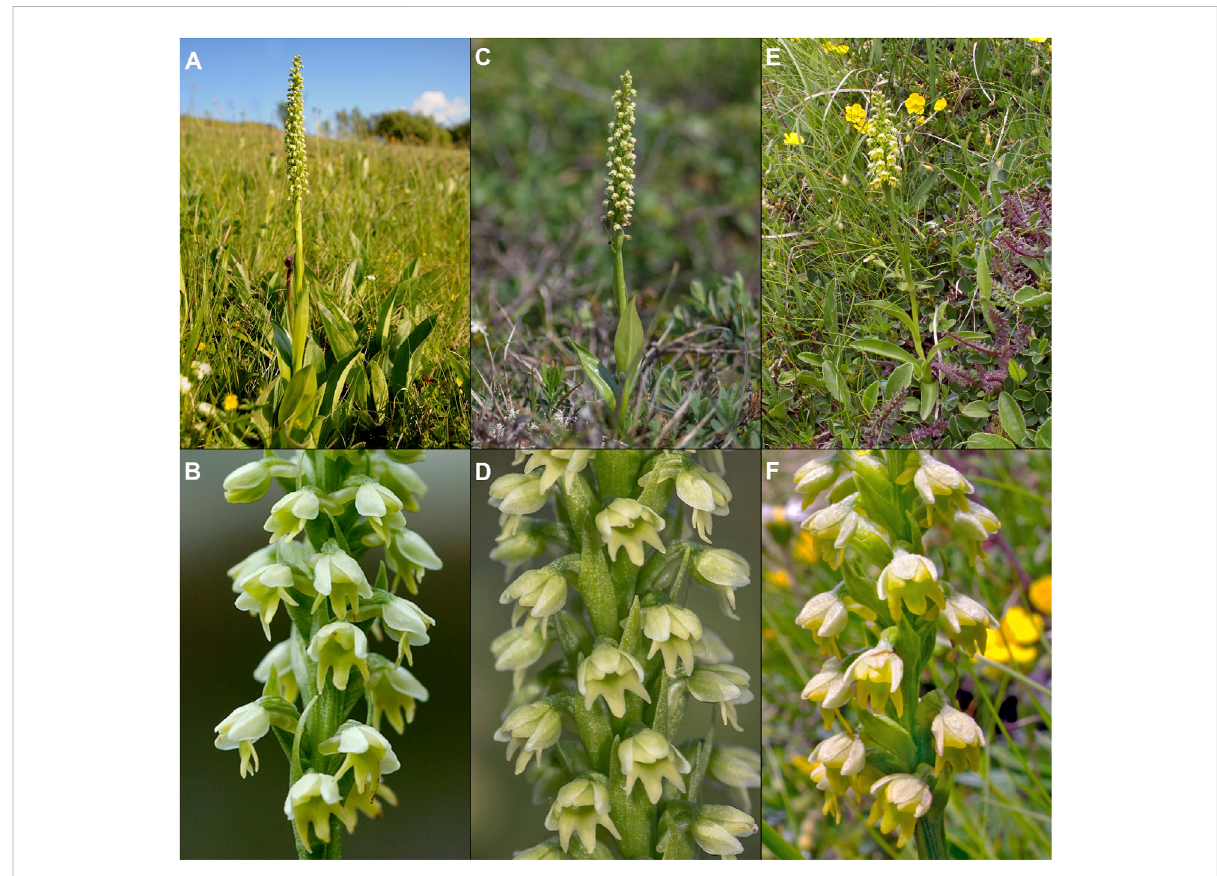
FIGURE 1 Photographs of the small-white orchid in its natural habitat. Pseudorchis albida ssp. albida in Rhön, Germany (A), and Zillertal Alps, Austria [ (B) ; photographer: Marco Klüber/www.m-klueber.de], Pseudorchis albida ssp. straminea in Newfoundland, Canada [ (C,D) ; photographer: James Fowler], and Pseudorchis albida ssp. tricuspis on Mt. Mangart, Julian Alps, Slovenia [ (E,F) ; photographer: Amadej